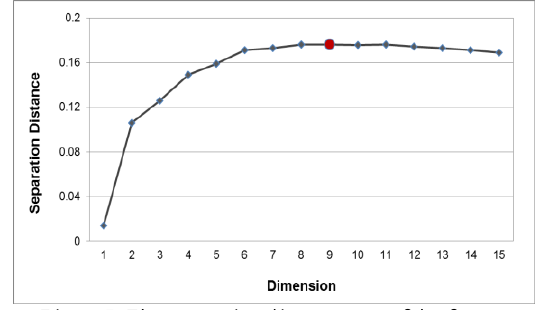
Figure 5. The separation distance map of the feature combination